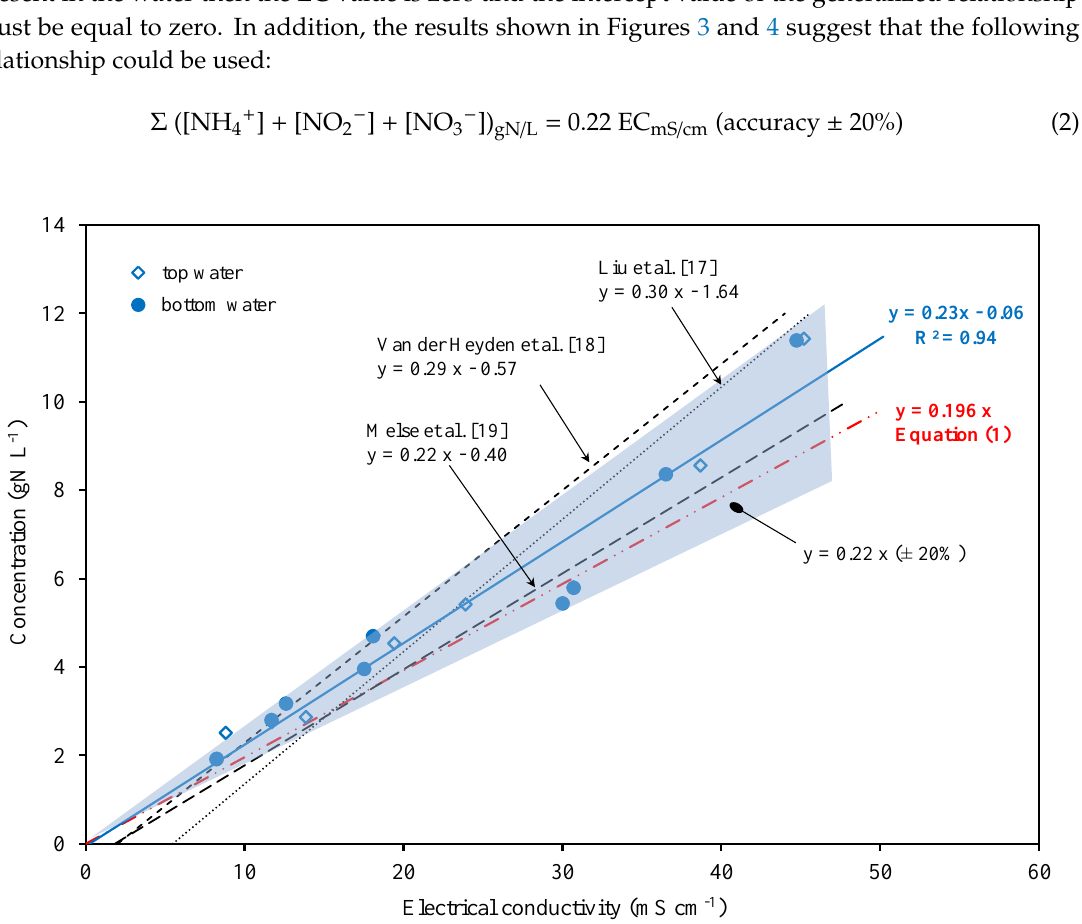
Figure 3. Electrical conductivity vs concentration in nitrogen ions ([NH 4 + ] + [NO 2 − ] + [NO 3 − ]) in water samples.